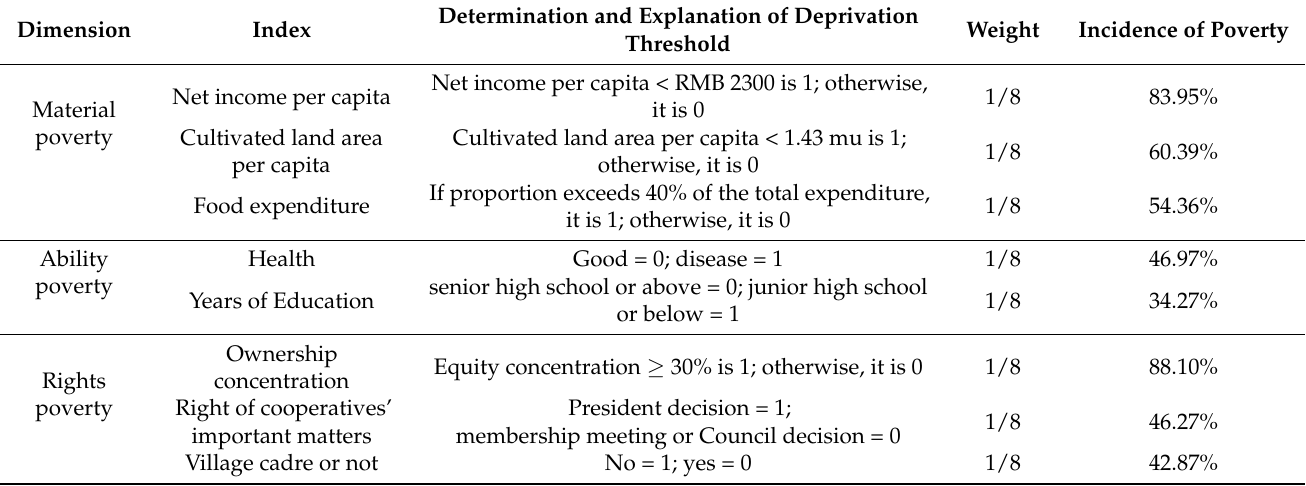
Table 1. Multidimensional poverty index of rural households and the explanation of deprivation